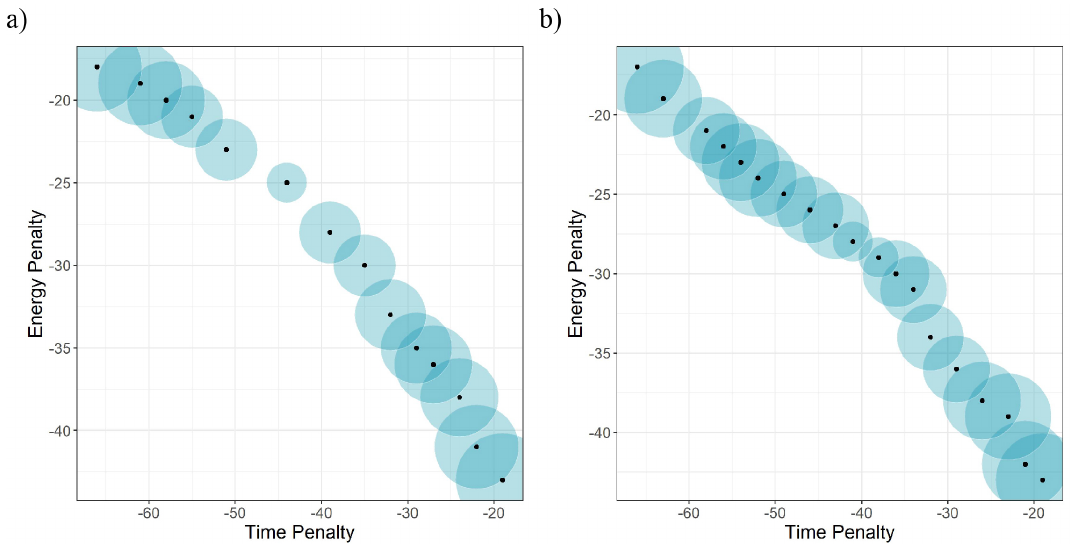
Figure 2. The black dots form the Pareto front we located throughout the experiment, and the blue circles portray by their sizes the numbers of solutions in proximity, indicating that larger circles contain more solutions. ( a ) is the conventional MO-V-MPO distribution, and ( b ) is the proposed method’s